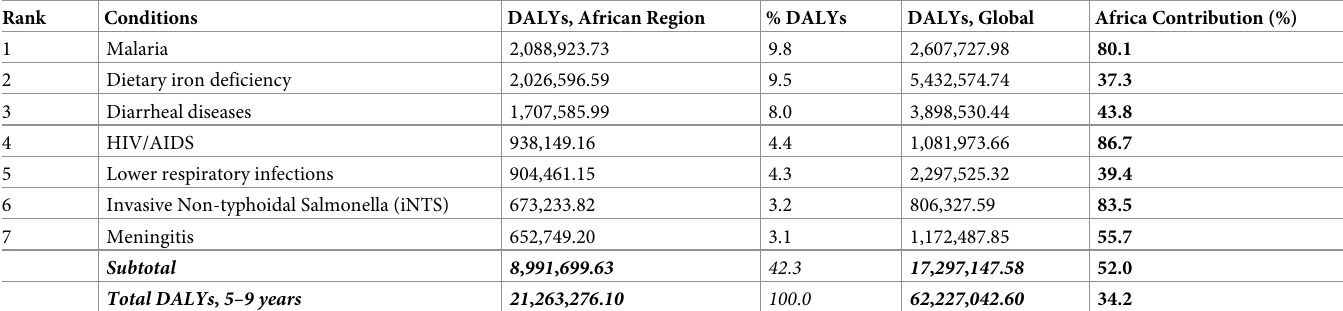
Table 5. Leading conditions in 5–9 age cohort in the Africa region, global and African region DALYs contribution,